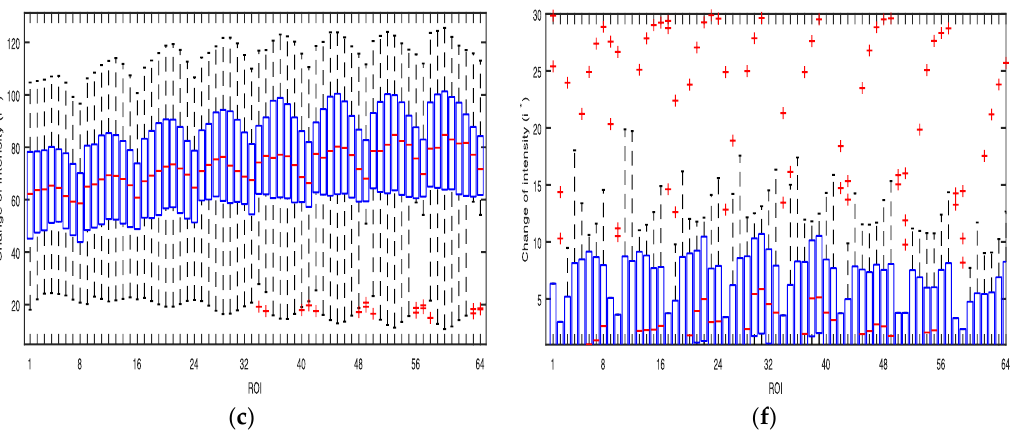
Figure 9. Box plot of the average values of 𝑖 ∗ of the three color bands obtained from the 64 ROIs of the Galaxy S6 and the Galaxy Note 3 from 30 subjects while shaking the cushion vertically: ( a ) Red (Galaxy S6); ( b ) Green (Galaxy S6); ( c ) Blue (Galaxy S6); ( d ) Red (Galaxy Note 3); ( e ) Green (Galaxy Note 3); ( f ) Blue (Galaxy Note 3). Table 3. The average values of 𝑖 ∗ of the three color bands obtained from 64 ROIs while shaking the cushion horizontally and vertically when the flashlight was on.